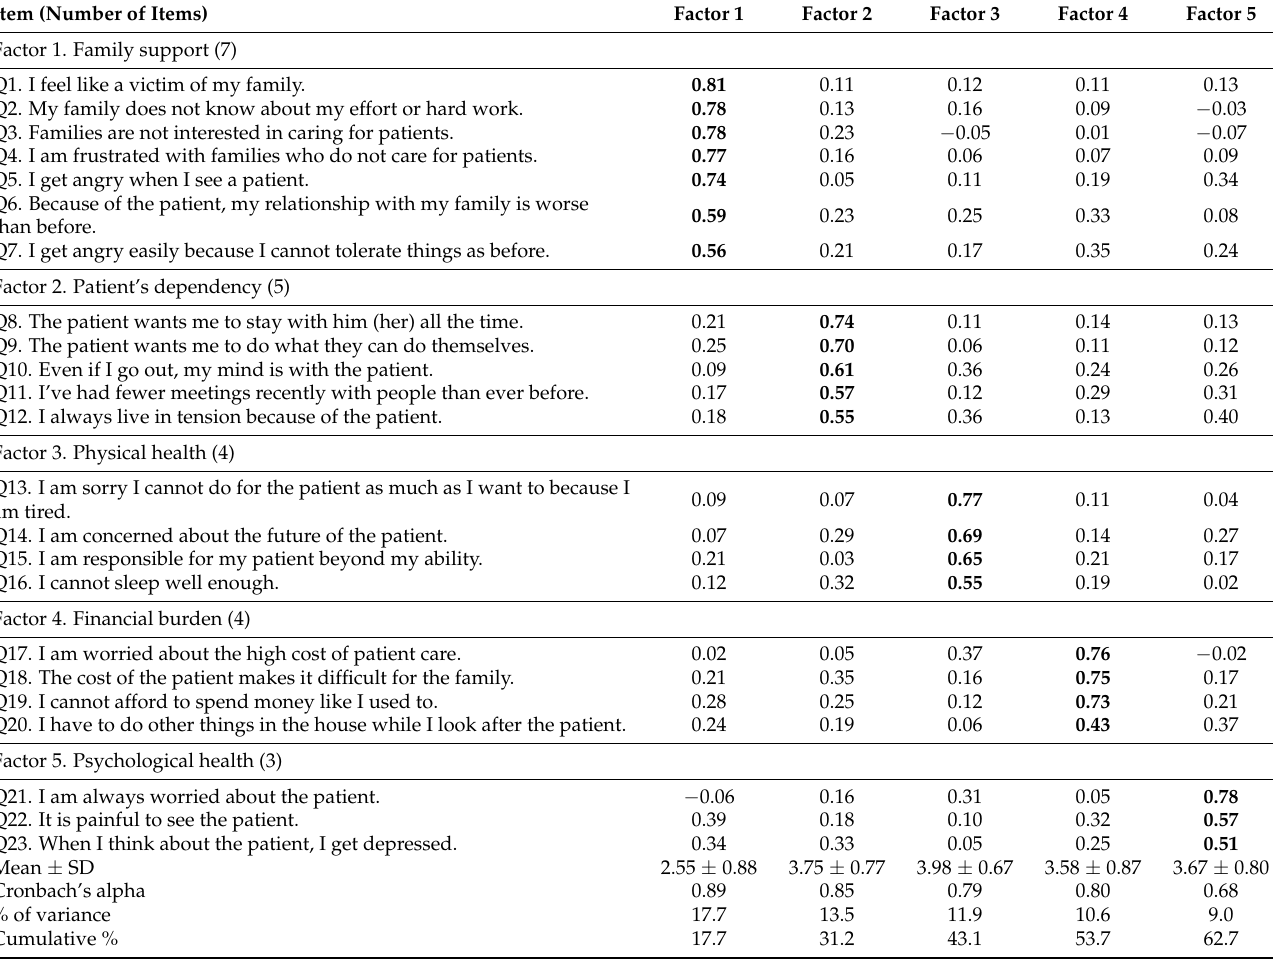
Table 2. Exploratory factor analysis and the reliability of the subscales (N =